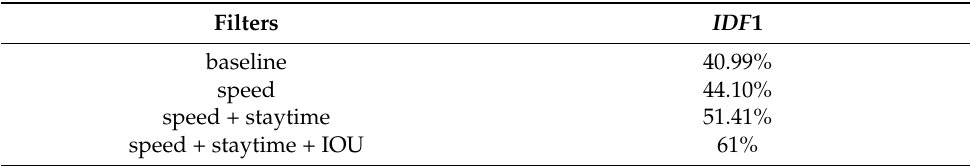
Table 2. The results of single-camera tracking filtering.